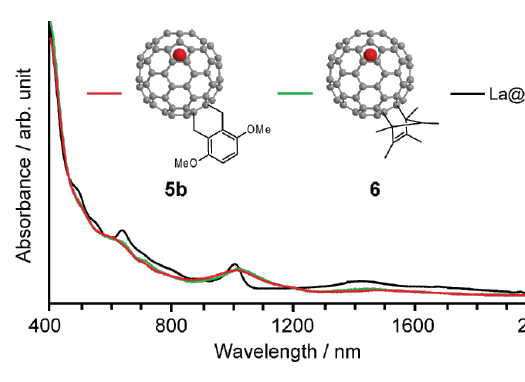
Figure 11: MALDI–TOF mass spectra (negative mode) of 5b , using 1,1,4,4-tetraphenyl-1,3-butadiene as matrix. Figure 12: Vis–near-IR spectra of 5b , 6 and La@C 82 in CS 2 .